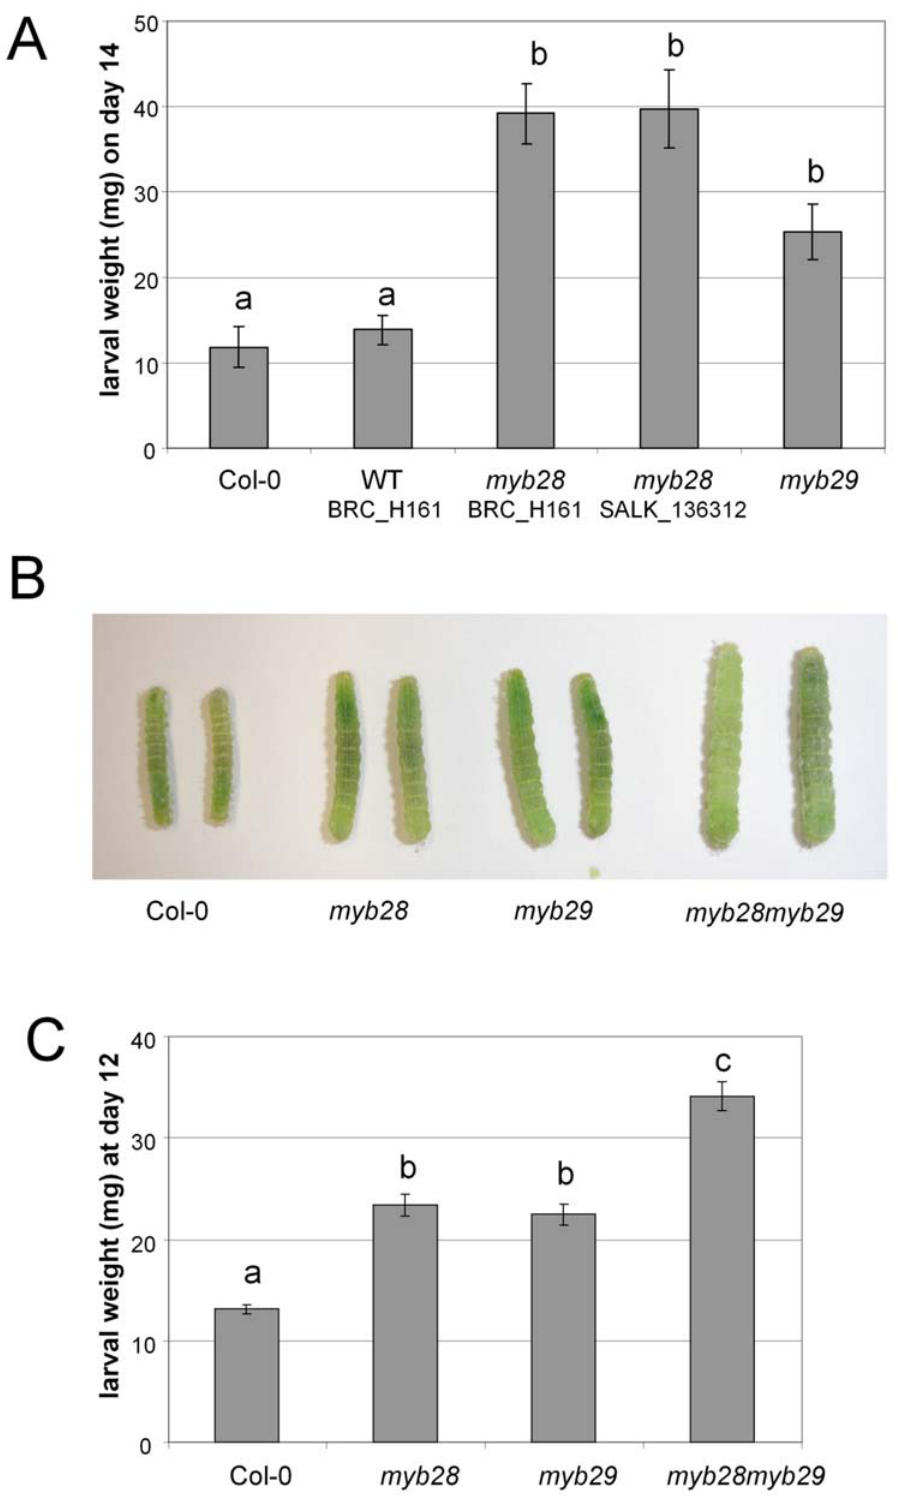
Figure 7. The effect of mutations in MYB genes on the interaction of Arabidopsis with Mamestrabrassicae . (A) Average larval weights on day 14 of the detached leaf experiment. Error bars indicate standard errors. Different characters over the bars indicate significant differences between the treatments after Tukey’s unequal N HSD analysis (p , 0.05). Col-0: n=12; WT BRC_H161: n=15; myb28 BRC_H161: n=17; myb28 SALK_136312: n=17; myb29: n=18. WT BRC_H161 is a wild type segregant obtained from the self fertilized progeny of a heterozygous MYB28myb28 (BRC_H161) plant. myb28 BRC_H161 and myb28 SALK_H636 are homozygous myb28 mutants carrying the BRC_H161b or the SALK_136312 T-DNA insert. myb29 is a homozygous myb29 mutant carrying the SM3.34316 transposable element insert. (B) Pictures of representative larvae captured from different mutant lines on day 12 of the whole-leaf experiment. (C) Average larval weights on day 12 of the whole plant experiment. Error bars indicate standard errors. Different characters over the bars indicate significant differences between the treatments after Tukey’s unequal N HSD analysis (p , 0.05). Col-0: n=24; myb28 : n=43; myb29 : n=51; myb28myb29 : n=53. doi:10.1371/journal.pone.0002068.g007 PLoS ONE |